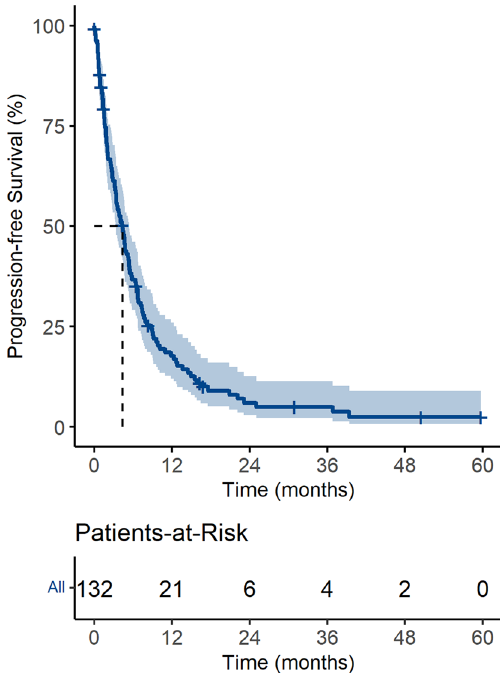
Figure 2. Progression-free survival in patients with CUP treated with